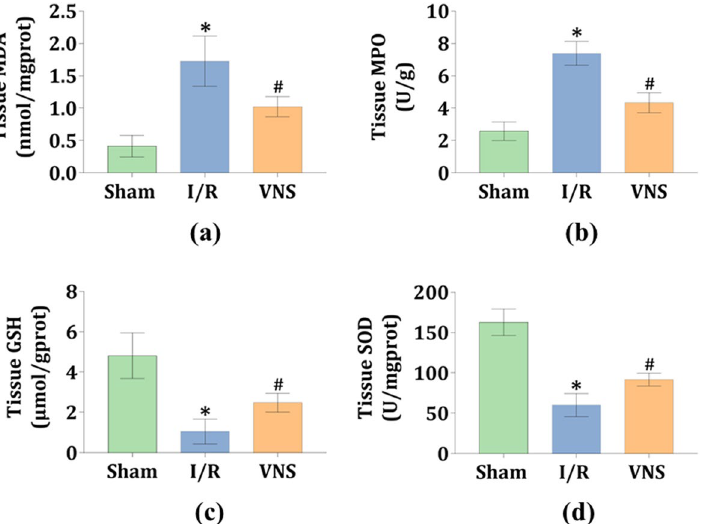
Figure 3. VNS attenuates oxidative stress in the kidneys after hepatic I/R injury. The effect of VNS on the levels of ( a ) MDA and ( c ) GSH in kidney tissues is shown. The effect of VNS on the activity of ( b ) MPO and ( d ) SOD in kidney tissues is shown. Data are expressed as mean ± SD. *p < 0.05 versus the Sham group; # p < 0.05 versus the I/R group. MDA myeloperoxidase, MPO malondialdehyde, GSH glutathione, SOD superoxide dismutase.